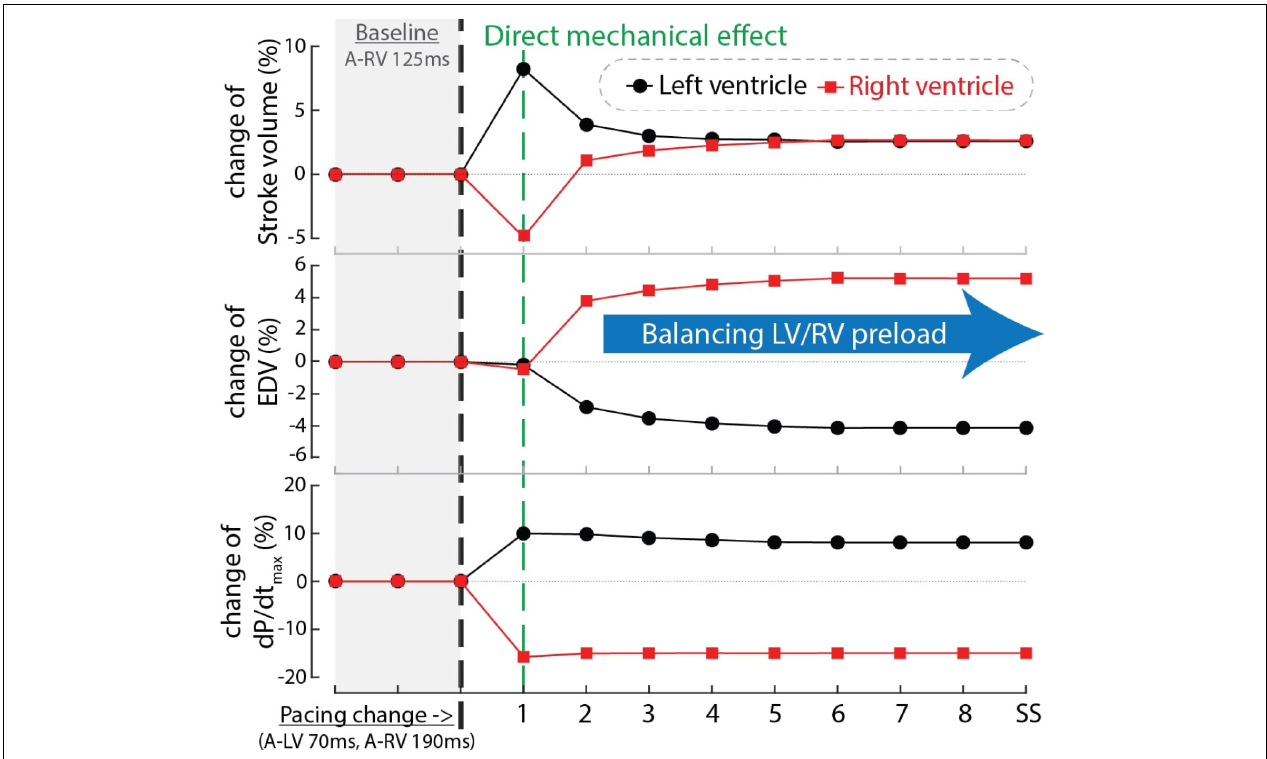
FIGURE 6 | Time courses of the relative change of stroke volume (top), end-diastolic volume (EDV, mid) and dP/dt max of the LV (black circles) and RV (red squares) after changing pacing delay from baseline (A-RV 125 ms) to LV pre-excitation (A-LV 70 ms, A-RV 190 ms) in computer simulations. The black dashed line indicates the start of the change in pacing delay. The numbers in the blue bar indicate the number of simulated cardiac cycles. SS, steady